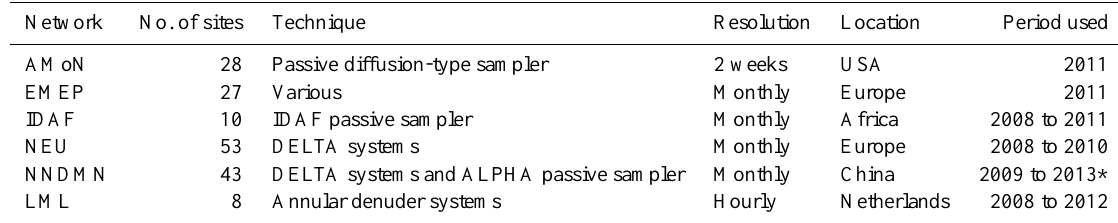
Table 1. Data sets used to compare with IASI satellite observations. Network No. of sites Technique Resolution Location Period used AMoN 28 Passive diffusion-type sampler EMEP 27 Various Monthly Europe IDAF 10 IDAF passive sampler NEU 53 DELTA systems NNDMN 43 DELTA systems and ALPHA passive sampler LML 8 Annular denuder systems